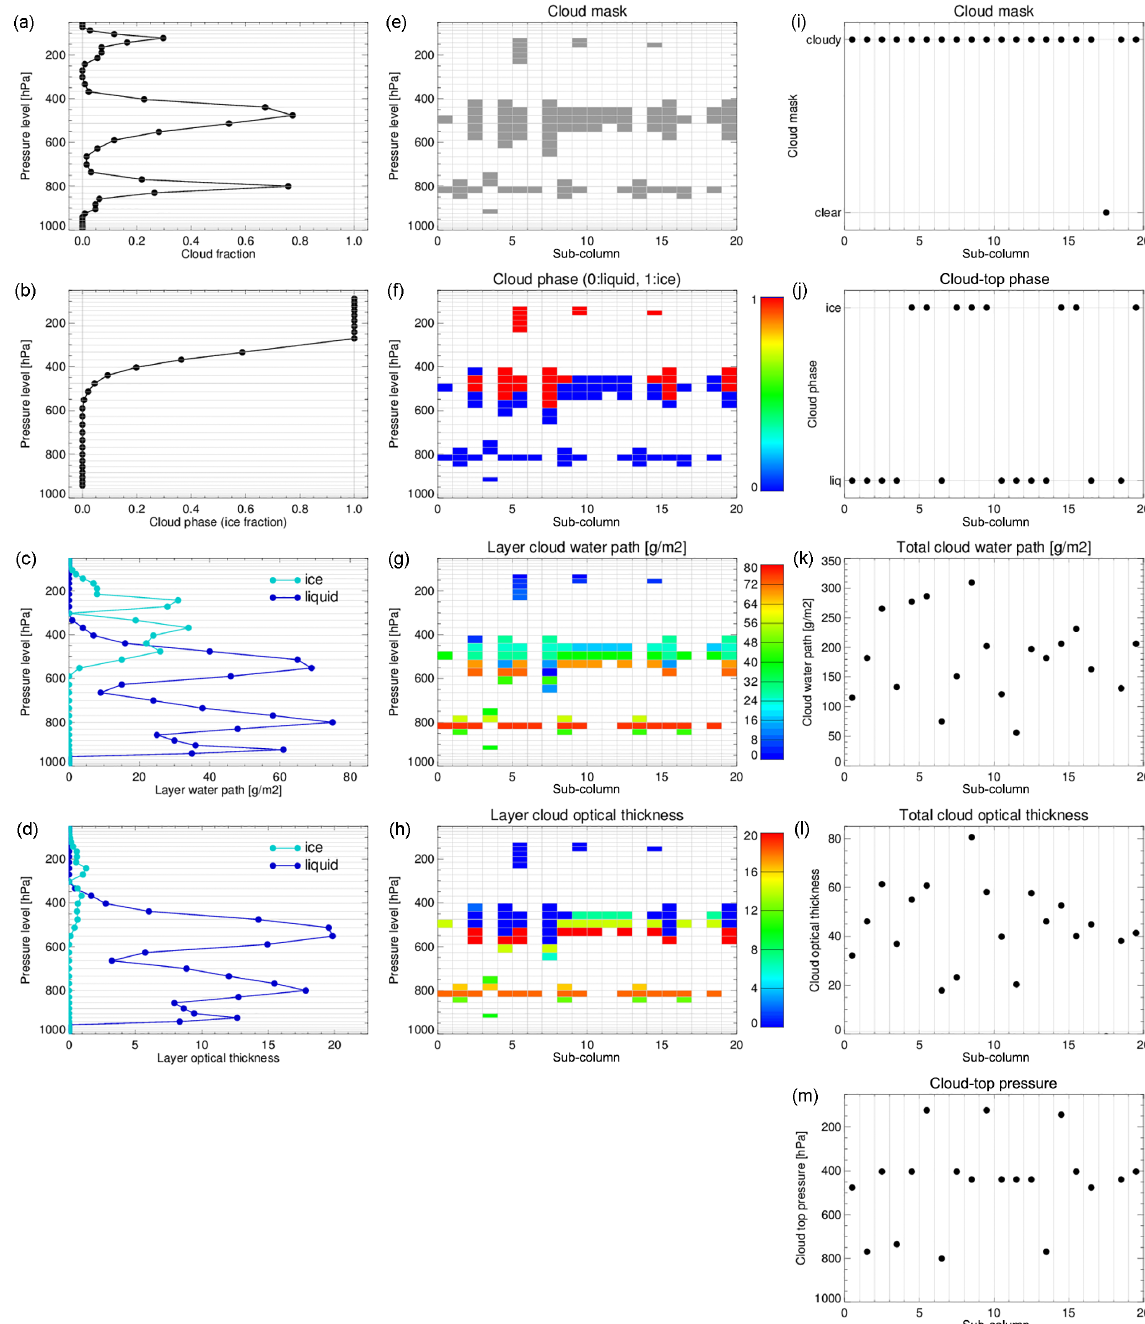
Figure 2. Example case for converting ERA-Interim grid box profiles to SIMFERA sub-columns and to pseudo-retrievals. The left column shows ERA-Interim-based profiles of cloud fraction (a) , cloud phase (b) , layer water path (c) and layer cloud optical thickness (d) . The middle column gives the same data after columnizing into 20 sub-columns that represent the sub-grid variability and after removing the uppermost cloud layers with layer optical thicknesses below a certain threshold (here 0.15): cloud mask (e) , cloud phase (f) , layer water path ( g , layer liquid and ice water path in liquid and ice cells) and layer optical thickness ( h , layer liquid and ice optical thickness in liquid and ice cells). The right panels show vertically summarized values per sub-column (also called pseudo-retrieval): cloud mask (i) , cloud-top phase (j) , vertically integrated water path (k) , vertically integrated optical thickness (l) and cloud-top pressure (m) . Each of these sub-column representative values can be seen as an individual pseudo satellite